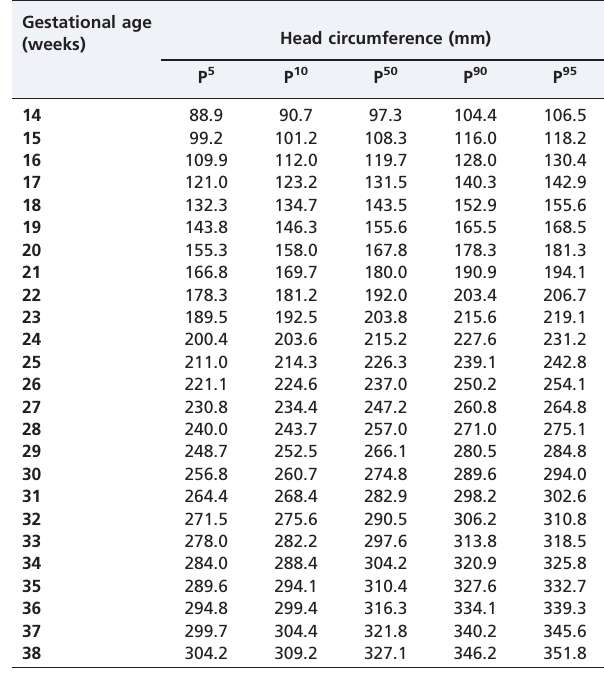
Table 2 - Longitudinal reference ranges for biparietal diameter based on 807 ultrasound examinations performed on 250 fetuses from 125 uncomplicated, twin pregnancies.